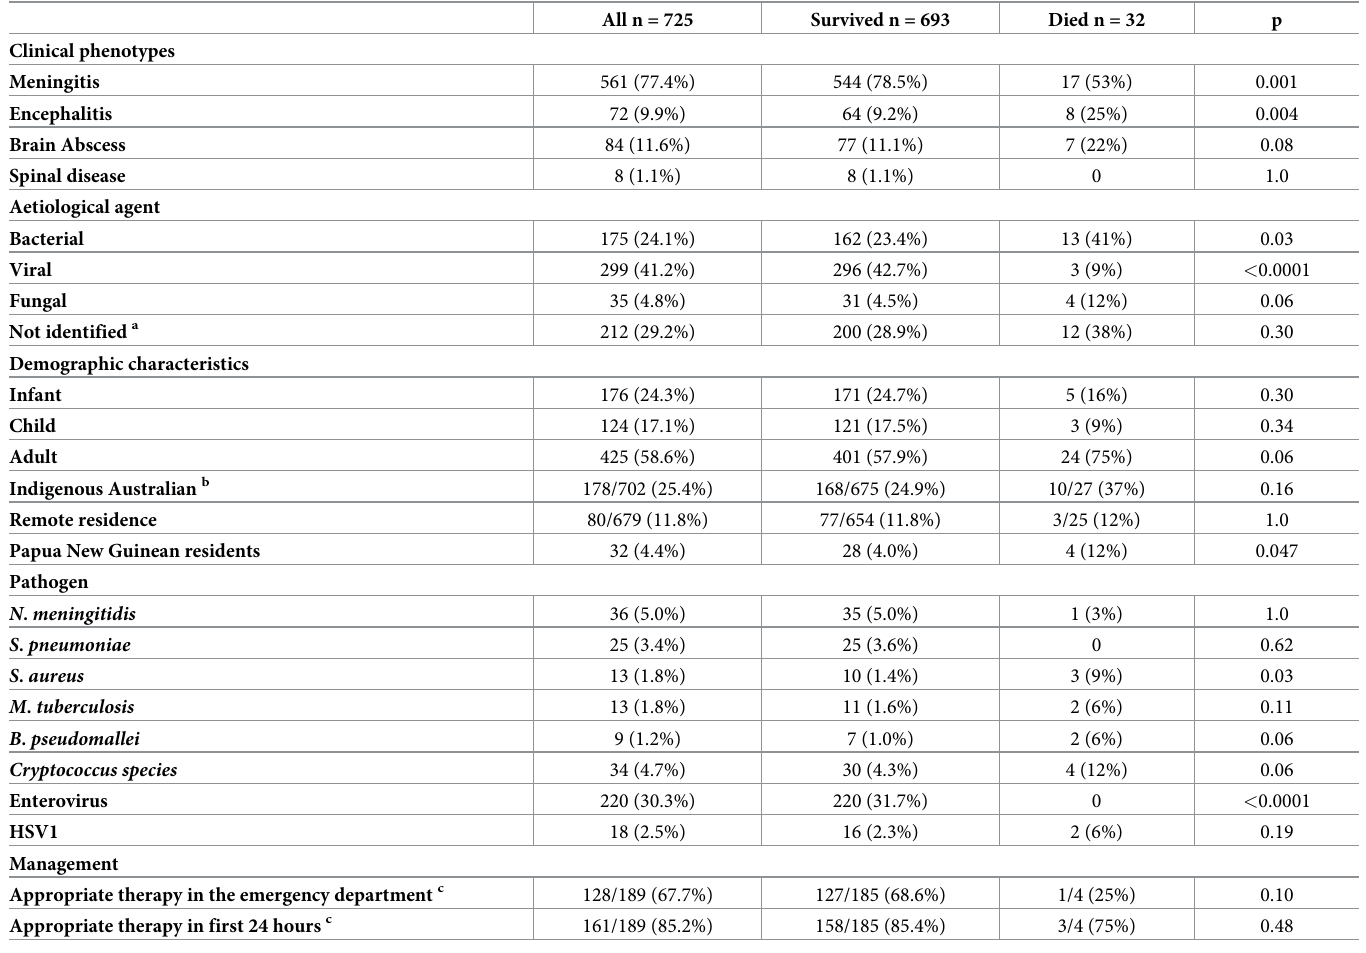
Table 8. The number of cases in those who survived and died, stratified by clinical phenotypes, demographic characteristics and